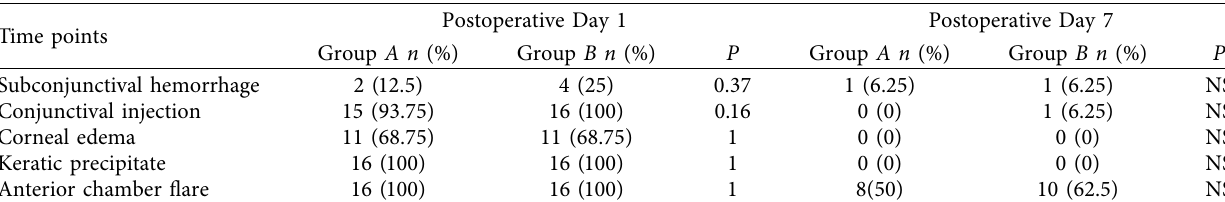
Table 3: Outcomes of postoperative inflammation